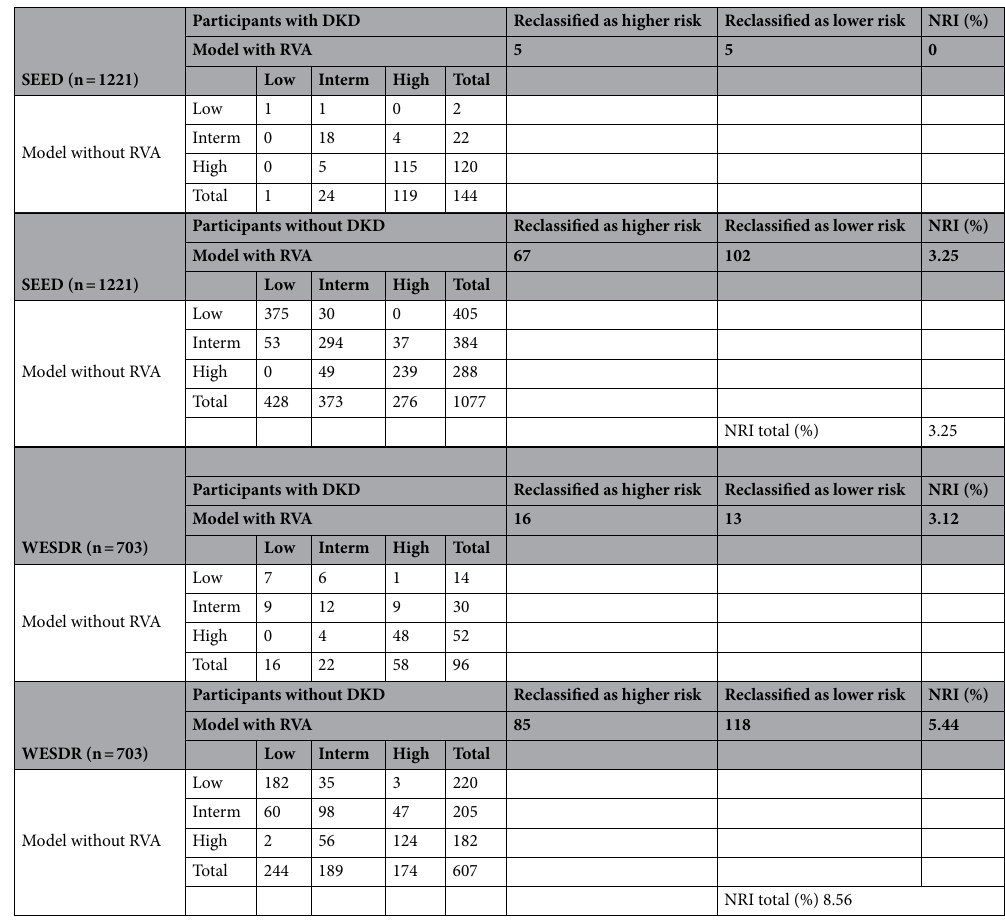
Table 3. Reclassification of diabetic kidney disease (DKD) risk after addition of retinal vascular abnormalities (RVA) in the prediction model in SEED (n = 1221) and WESDR (n = 703). The risk thresholds for DKD prediction correspond to the tertiles of predicted values in the model without RVA (SEED: low: 0–2.6%; Intermediate: 2.6–10.7%; and high: > 10.7%; WESDR: low: 0–8.8%; Intermediate: 8.8–15.5%; and high: >